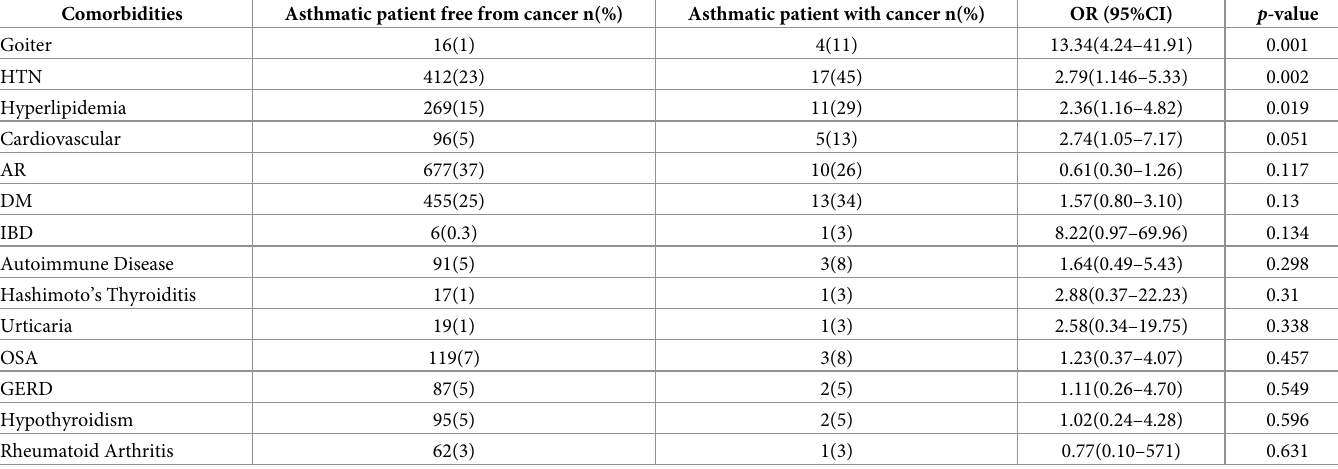
Table 3. Association between cancer among asthma patients and other co-morbidities.